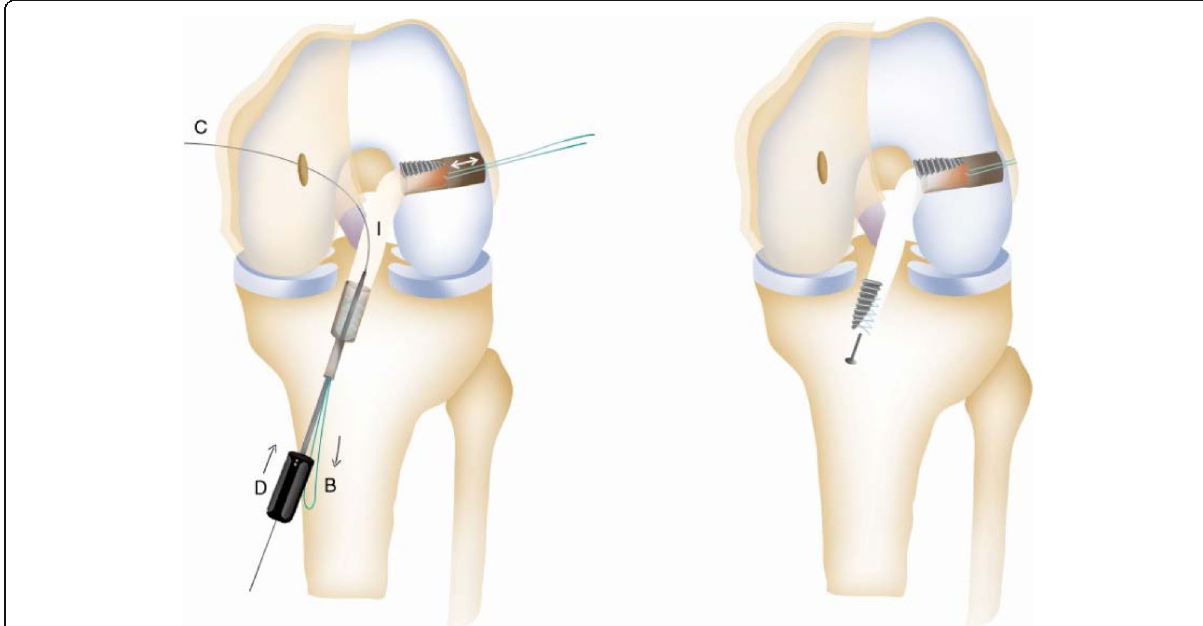
Fig. 5 Graft fixation. 1- Sliding of the Retrodriver (D) on the nitinol wire (c) and femoral fixation with interference screw. 2- Tibial Fixation with Retroscrew. B. Krakow suture; C Nitinol eyeled wire; I QT Graft; D